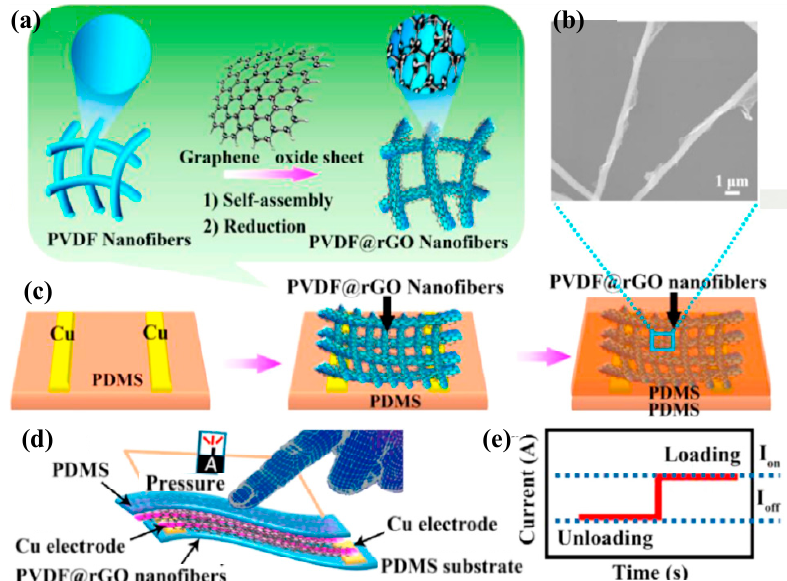
Figure 5. ( a ) Schematic illustration of the mechanism for the formation of PVDF fibers coated by the